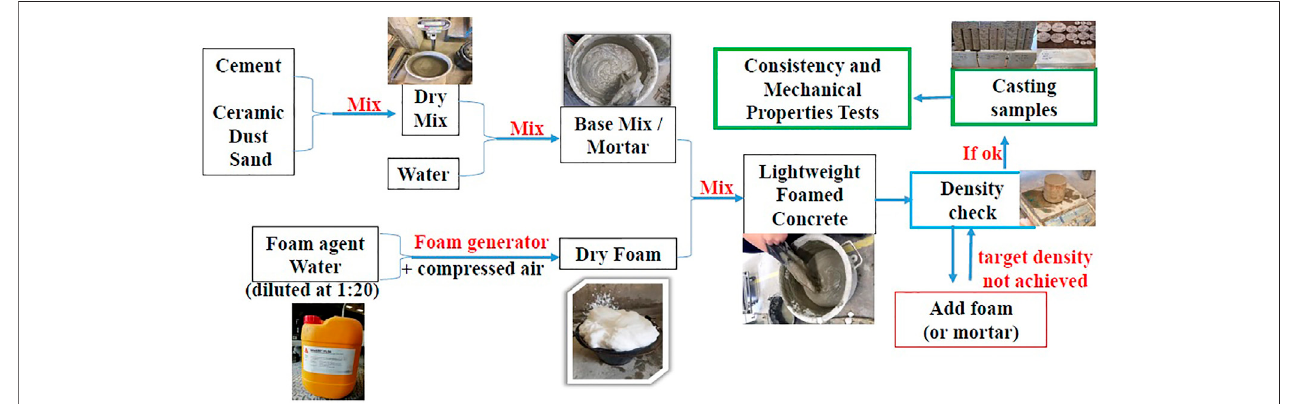
FIGURE 1 | Graphical abstract of this study.